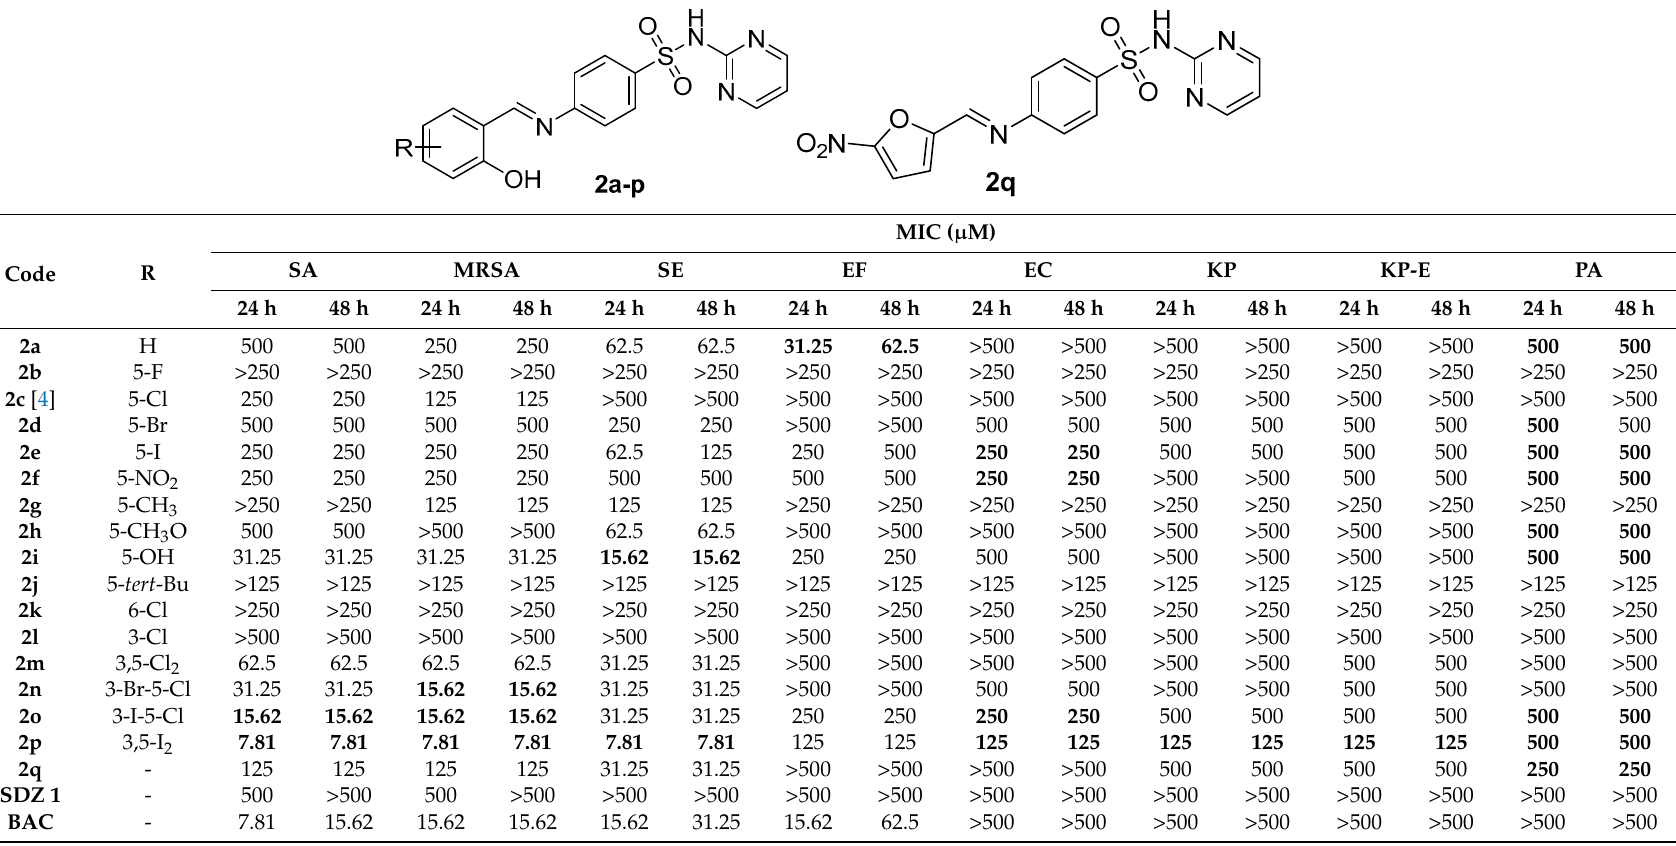
Table 1. Antibacterial activity of sulfadiazine derivatives 2 .